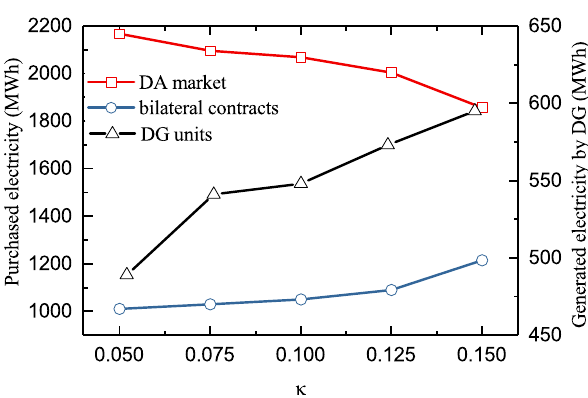
Figure 6. Volumes of electricity purchased under different κ